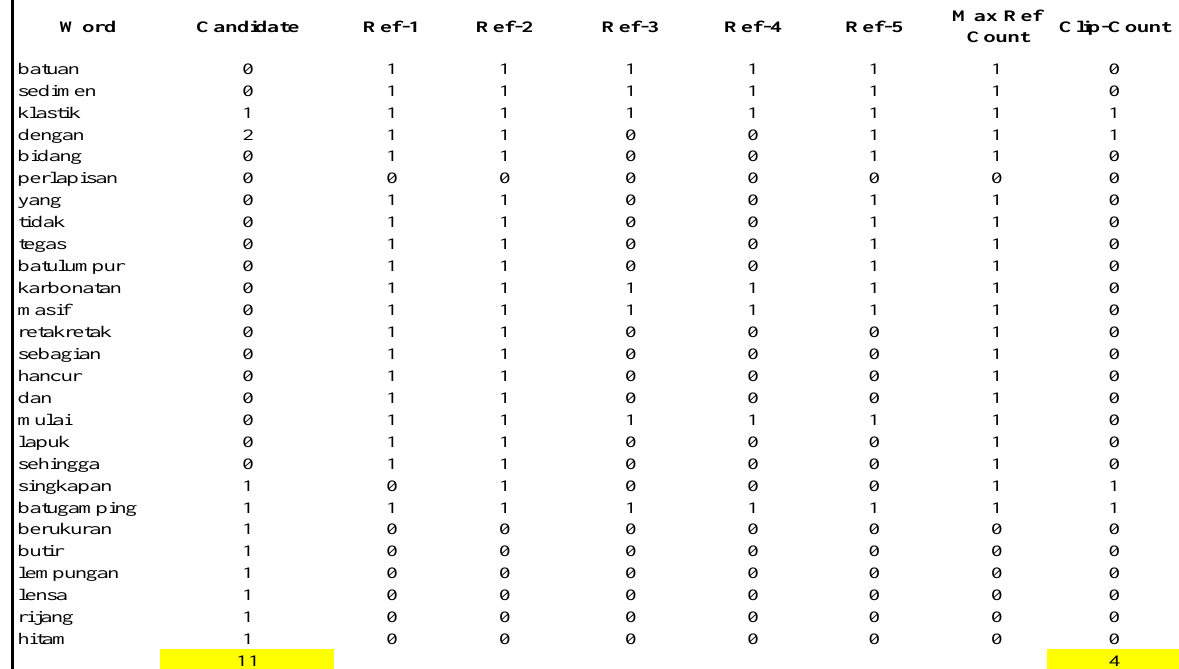
Figure 7. Collecting tokens taken from reference and candidate captions in Indonesian. Candidate is the number of words from the caption generation, ref-n is the number of words that have a similar word as the candidate, Max ref count is a value from selecting Max (candidate, ref-n), and clip_count is a value of Min (candidate, Max ref count). The yellow color is sum of candidate and sum of cli- of count.